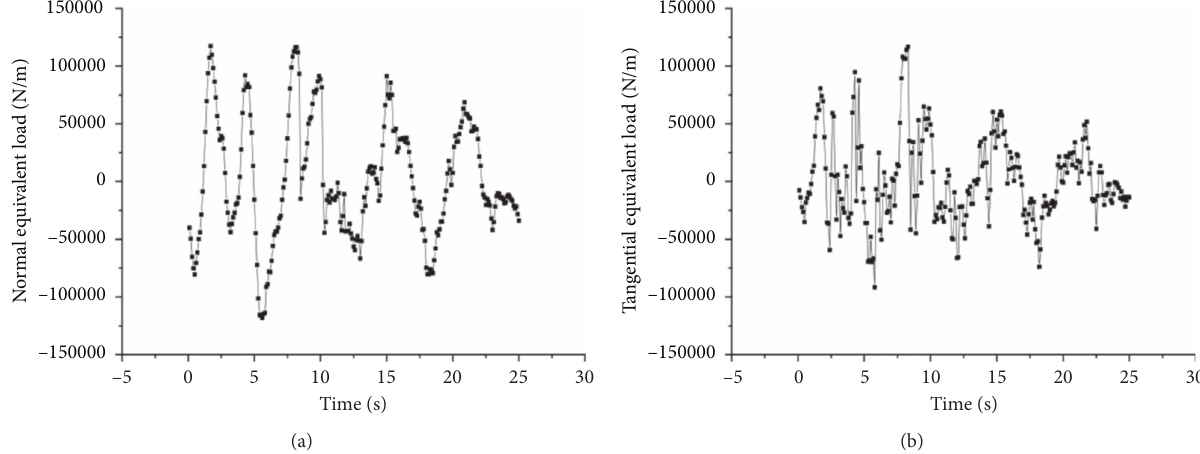
( t ) -time curve. (b) Tangential equivalent load BN